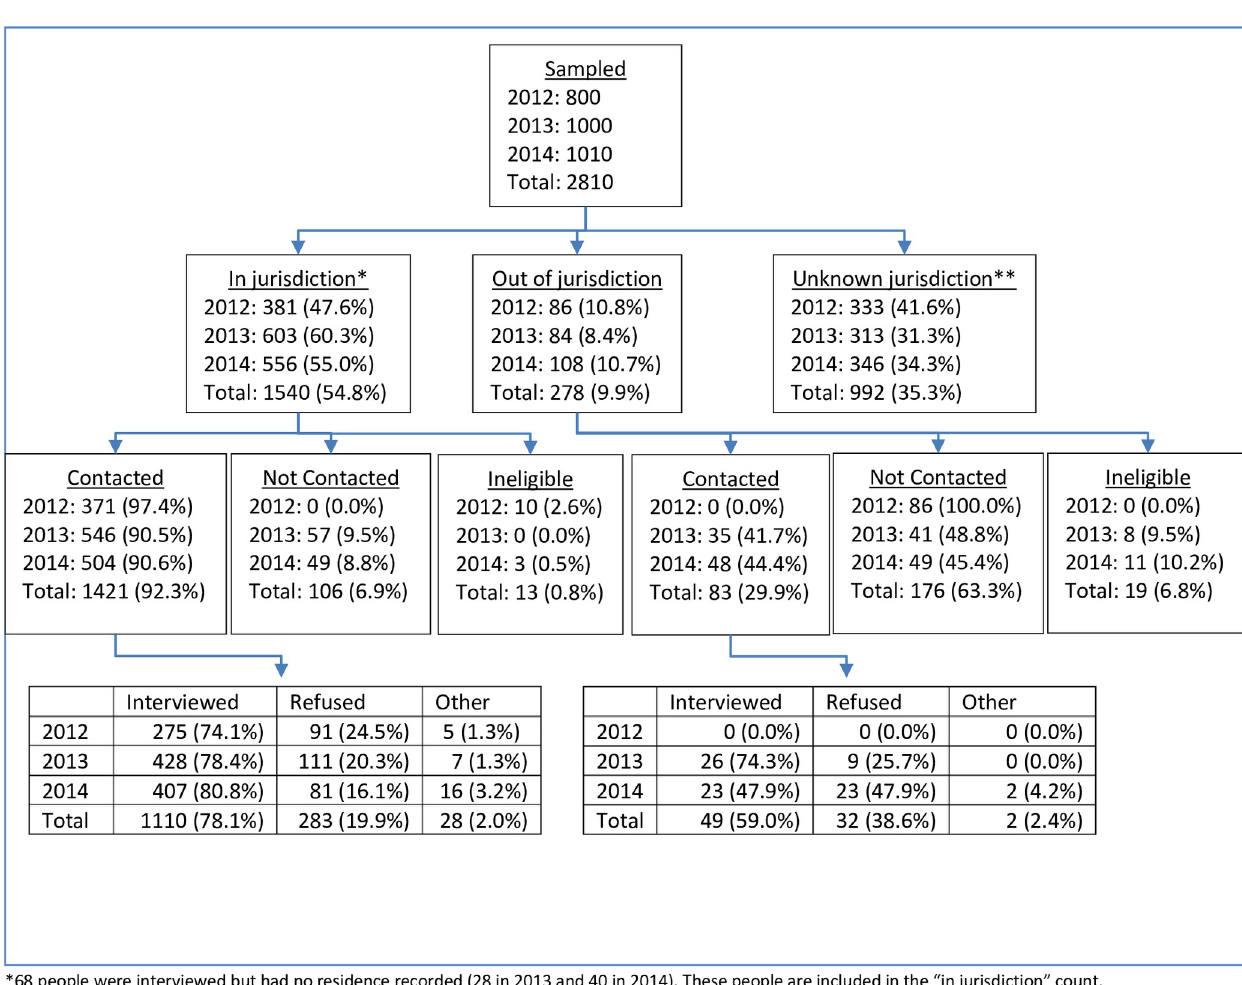
PLOS ONE | https://doi.org/10.1371/journal.pone.0219996 August 1,